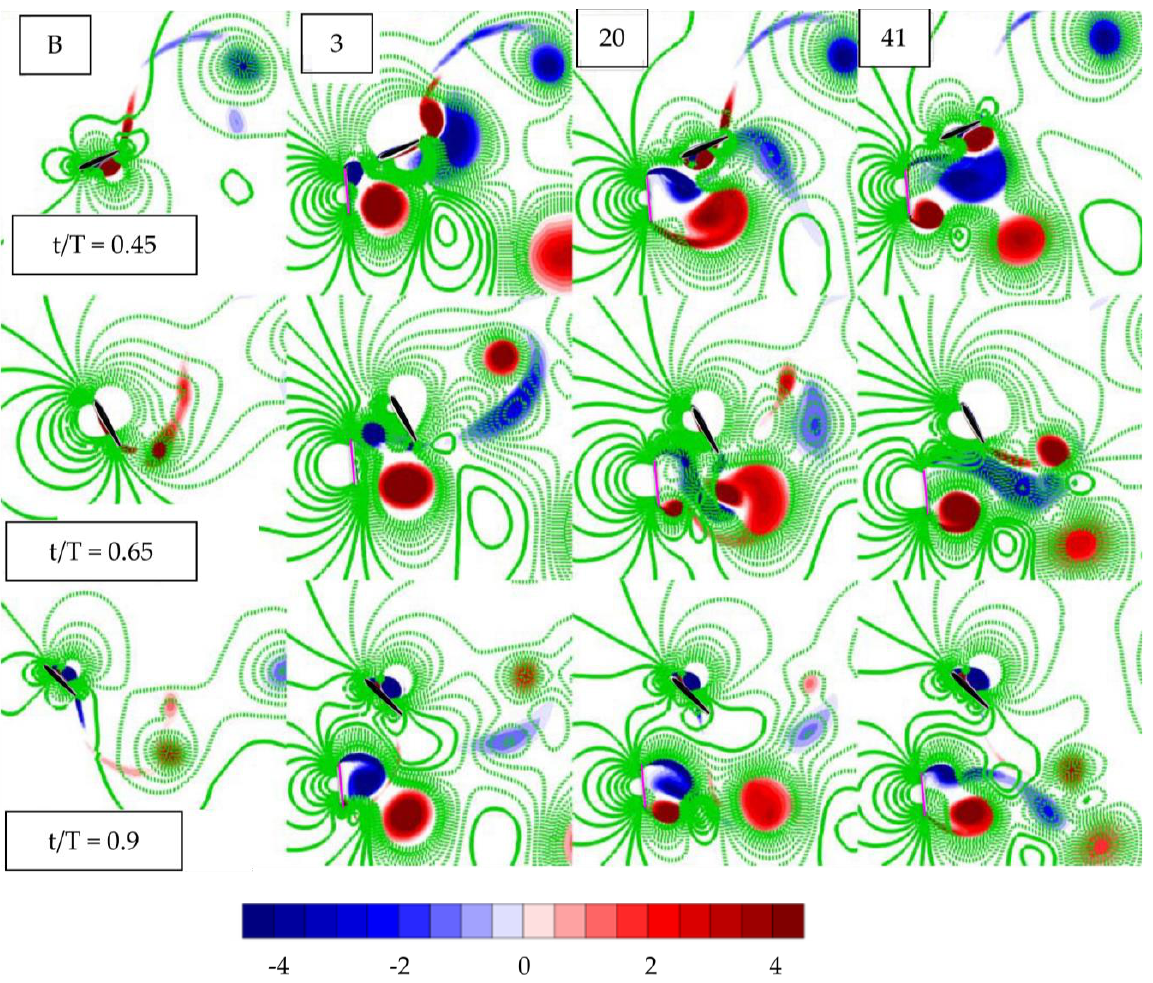
Figure 15. A comparison of the vortex structures and isolines of pressure of a hydrofoil with an upstream deflector at different deflector–hydrofoil spacings J * during upstroke (solid isolines: positive pressure; dashed isolines: negative pressure).